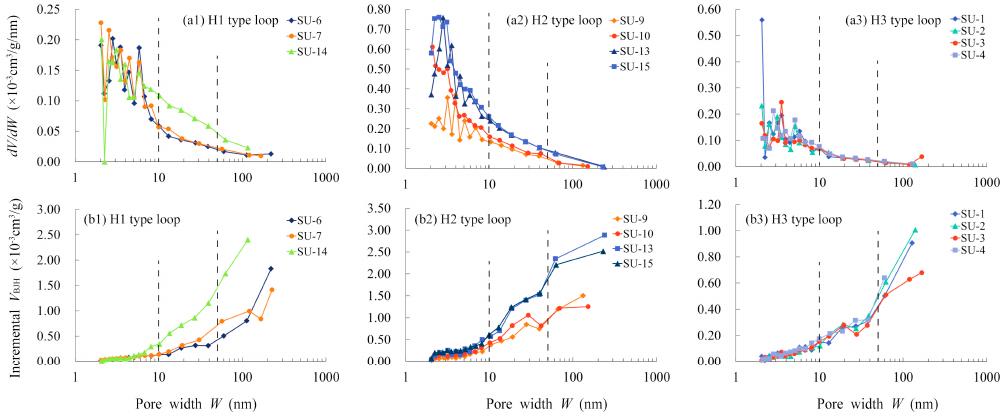
Figure 8. Representative pore size of different hysteresis loop types tight sandstone: ( a1 )–( a3 ) dV/dW vs . PW, ( b1 )–( b3 ) Incremental V BJH vs . PW.